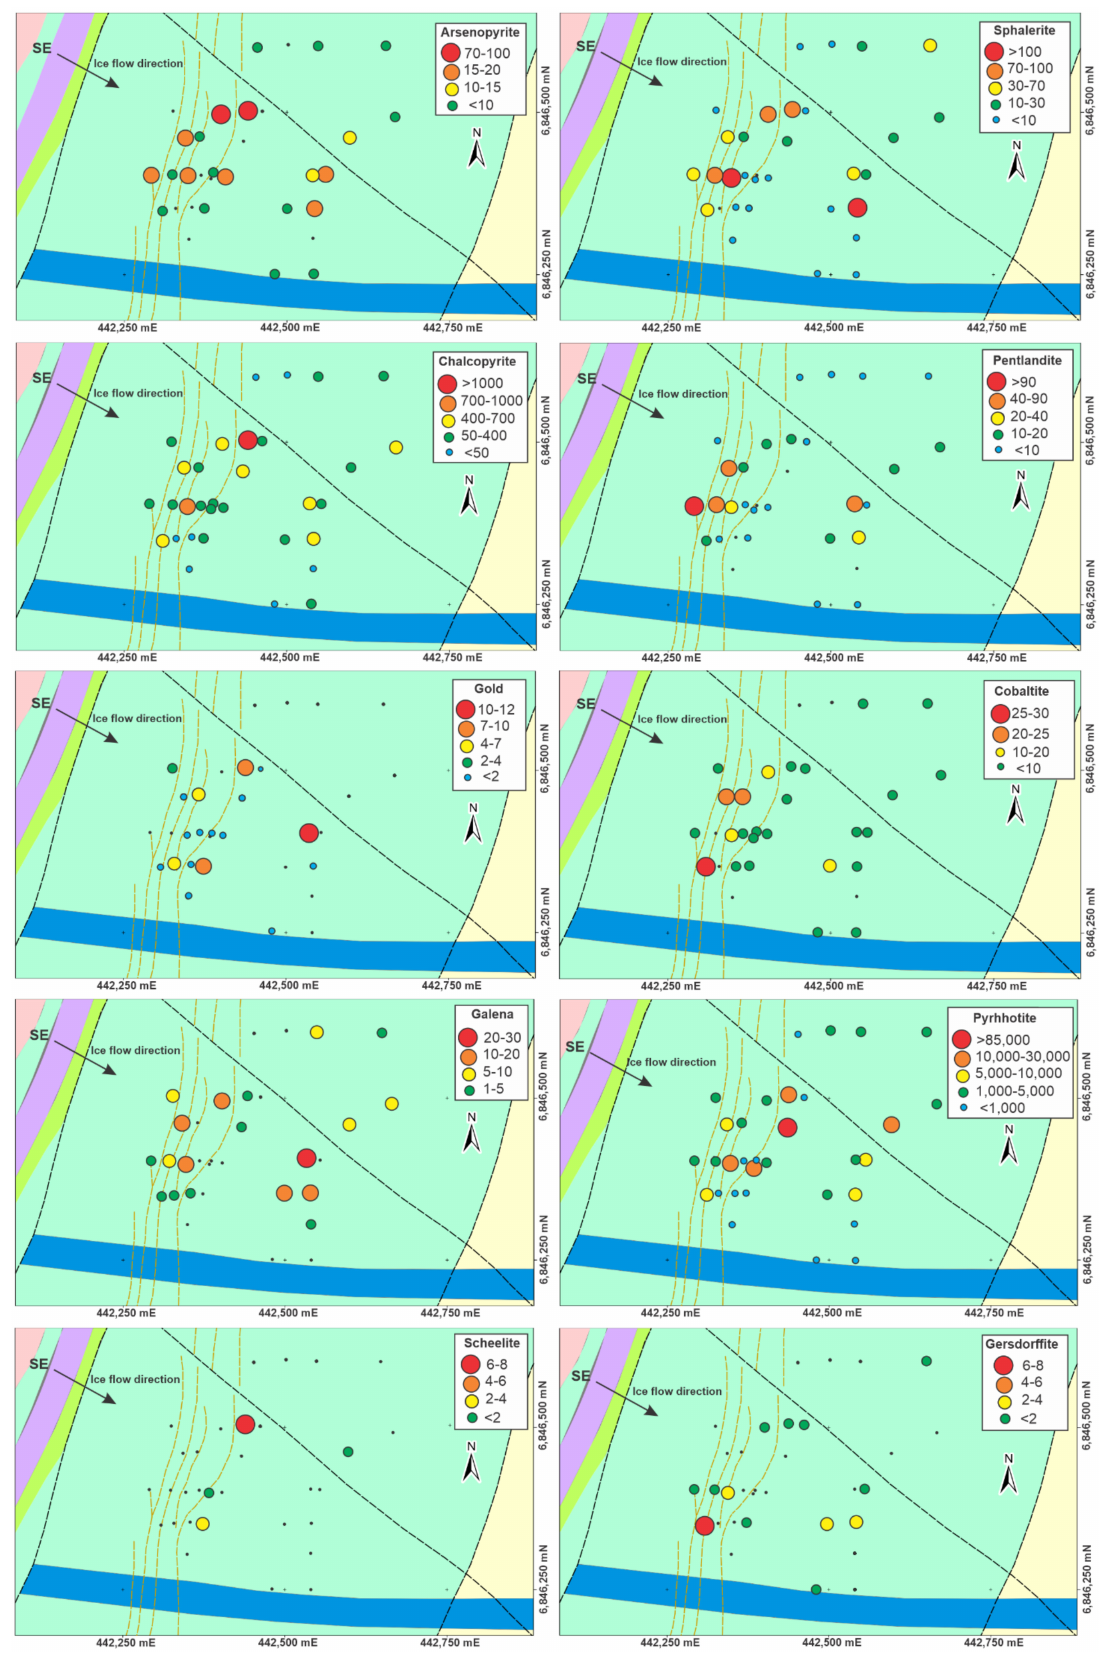
Figure 14. Bubble plot of the number of indicator minerals separated from the lowermost 1 m of the Permian cover of 32 RC drill holes (Figure 2) showing the mineral particle counts, which include the free grains and the mineral inclusions of